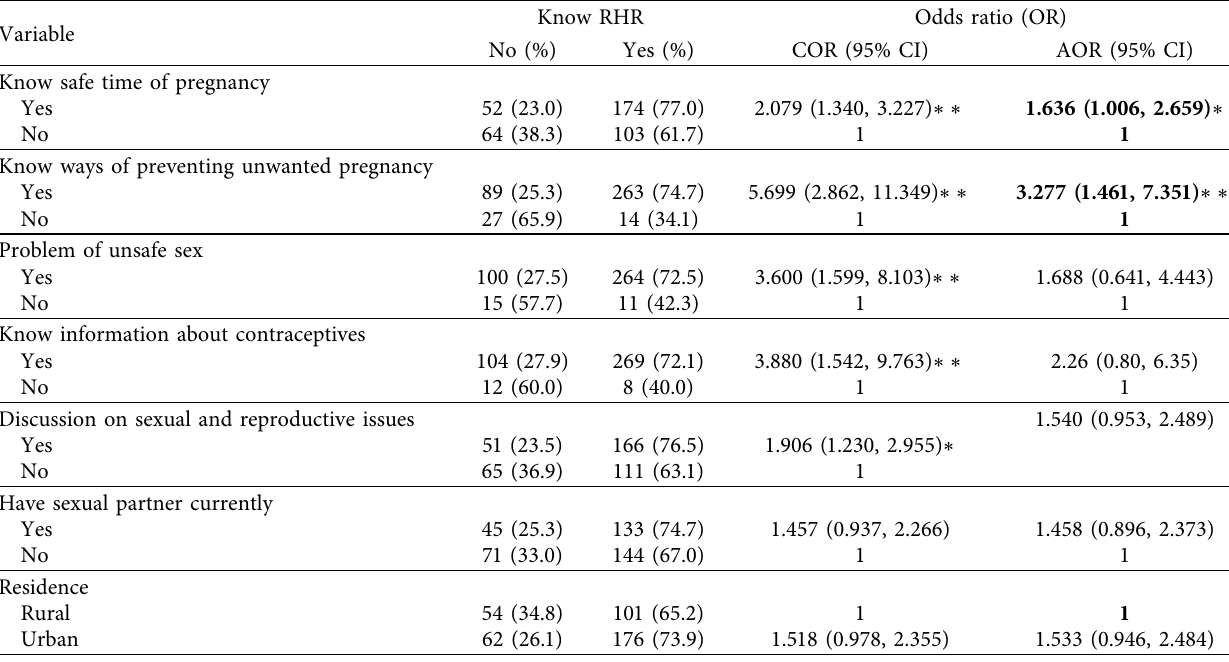
Table 5: Factors affecting knowledge of reproductive health rights among preparatory school female students, Assela, Ethiopia, 2015. Variable